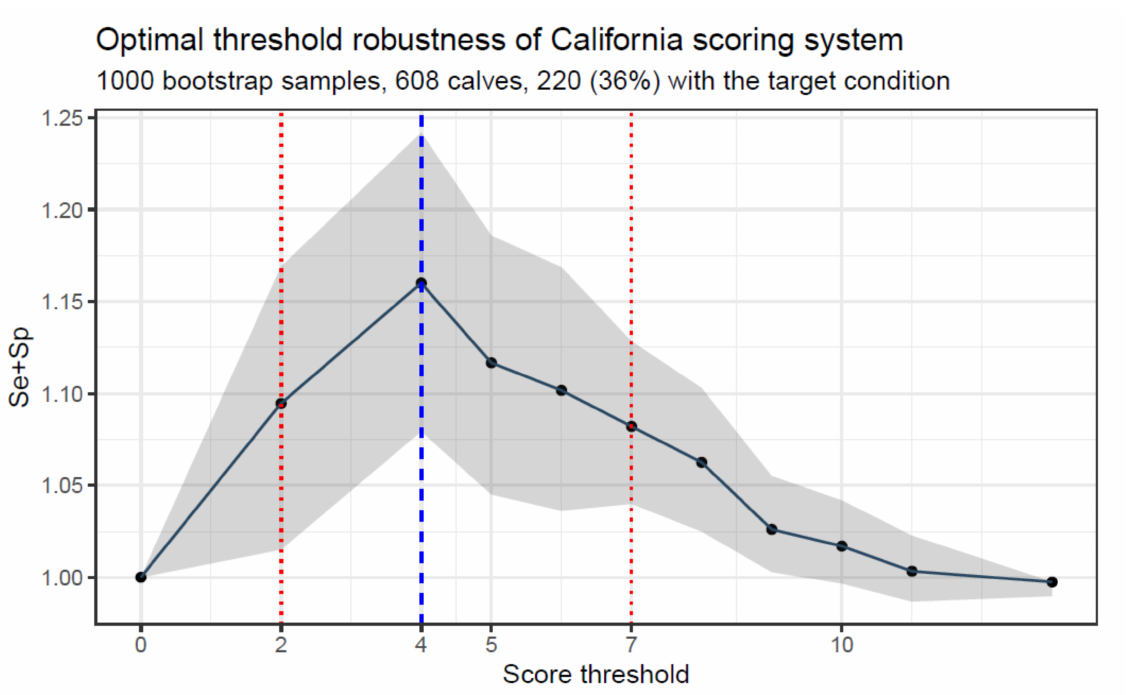
Figure 4. Determination of the optimal threshold based on a specific score. This figure represents the California respiratory score threshold for detecting ultrasonographic lung consolidation (target condition defined as a maximal consolidation depth ≥ 1 cm) in 608 pre-weaned calves from 39 different dairy herds [9]. The accuracy of the score is presented in the y-axis with the sum of sensitivity (Se) and specificity (Sp) of the score depending on the threshold ( ≥ threshold to define a positive score, < for a negative score). The dots represent the observed value of the score, and the 95% confidence interval band was obtained after 1000 bootstrap estimates. Even though the threshold of ≥ 4 is numerically associated with the highest accuracy (dashed blue line), there is no evidence that this threshold is better than any threshold between 2 and 7 (dotted red lines) due to the confidence interval